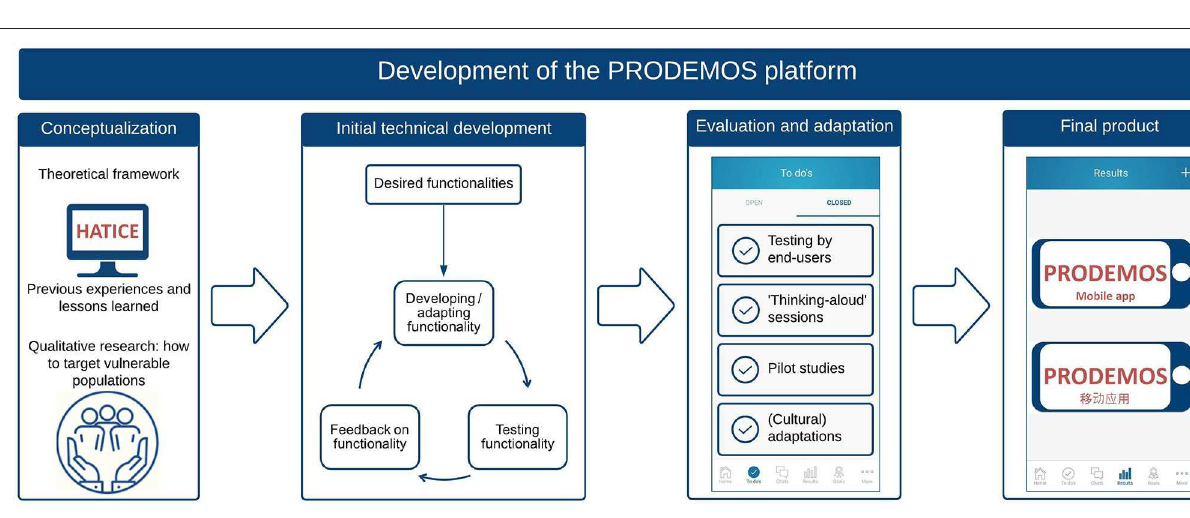
FIGURE 2 | Phases of development of the PRODEMOS